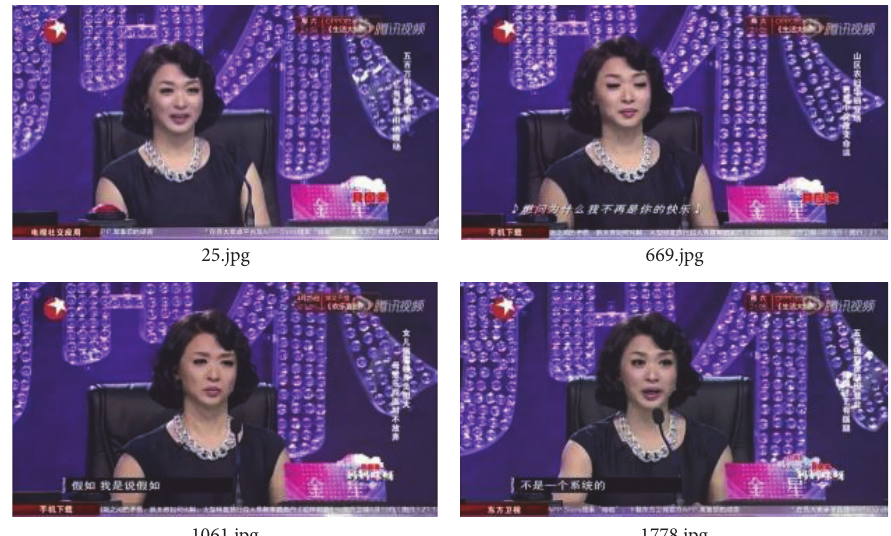
Figure 2: Four frames with similar content extracted from a tested video.